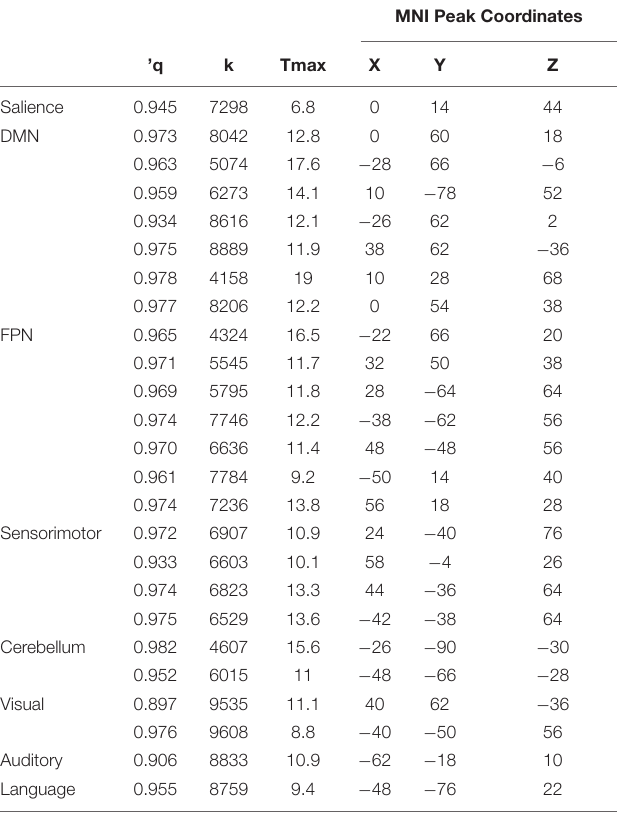
TABLE 2 | Properties of Independent Components